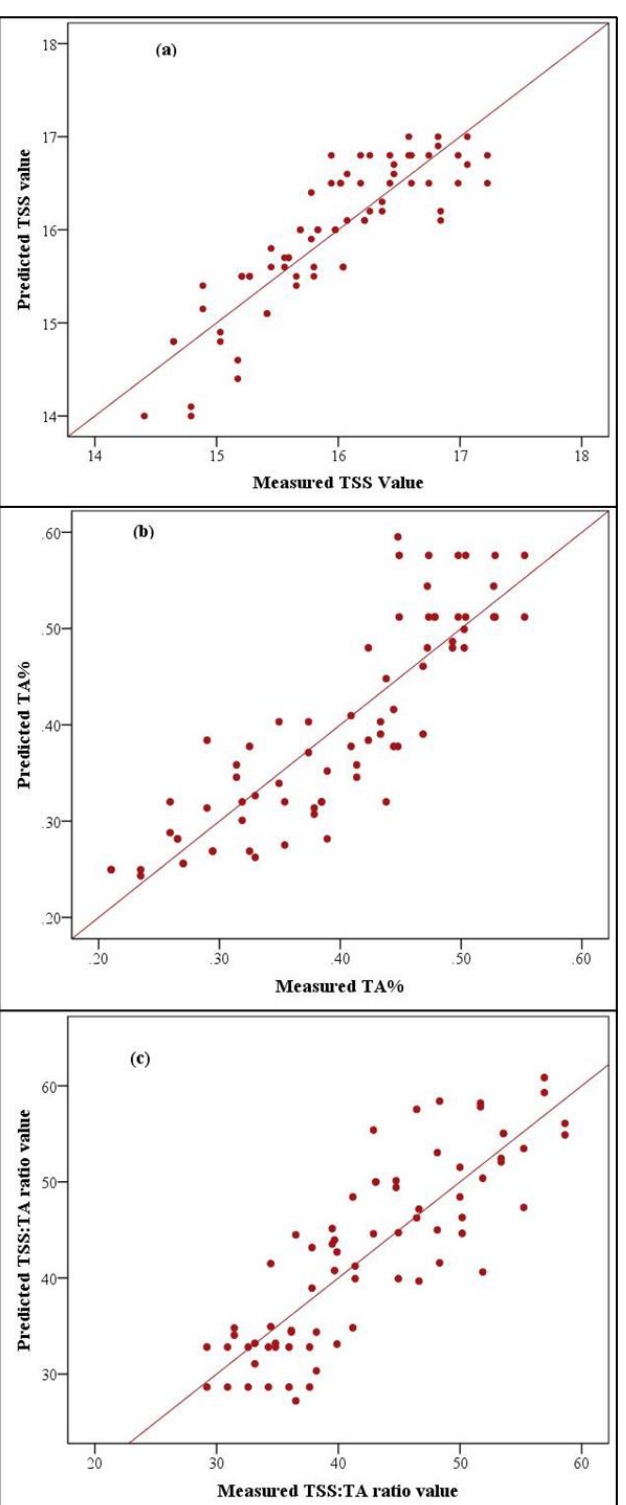
Figure 6. Results for the prediction of total soluble solids ( TSS ) ( a ), titratable acidity ( TA% ) ( b ), and sugar:acid ratio ( TSS:TA ) ( c ) values based on a linear regression model. Predicted TSS versus measured TSS (Model 2). Predicted TA versus measured TA (Model 3). Predicted TSS:TA versus measured TSS:TA (Model 4).